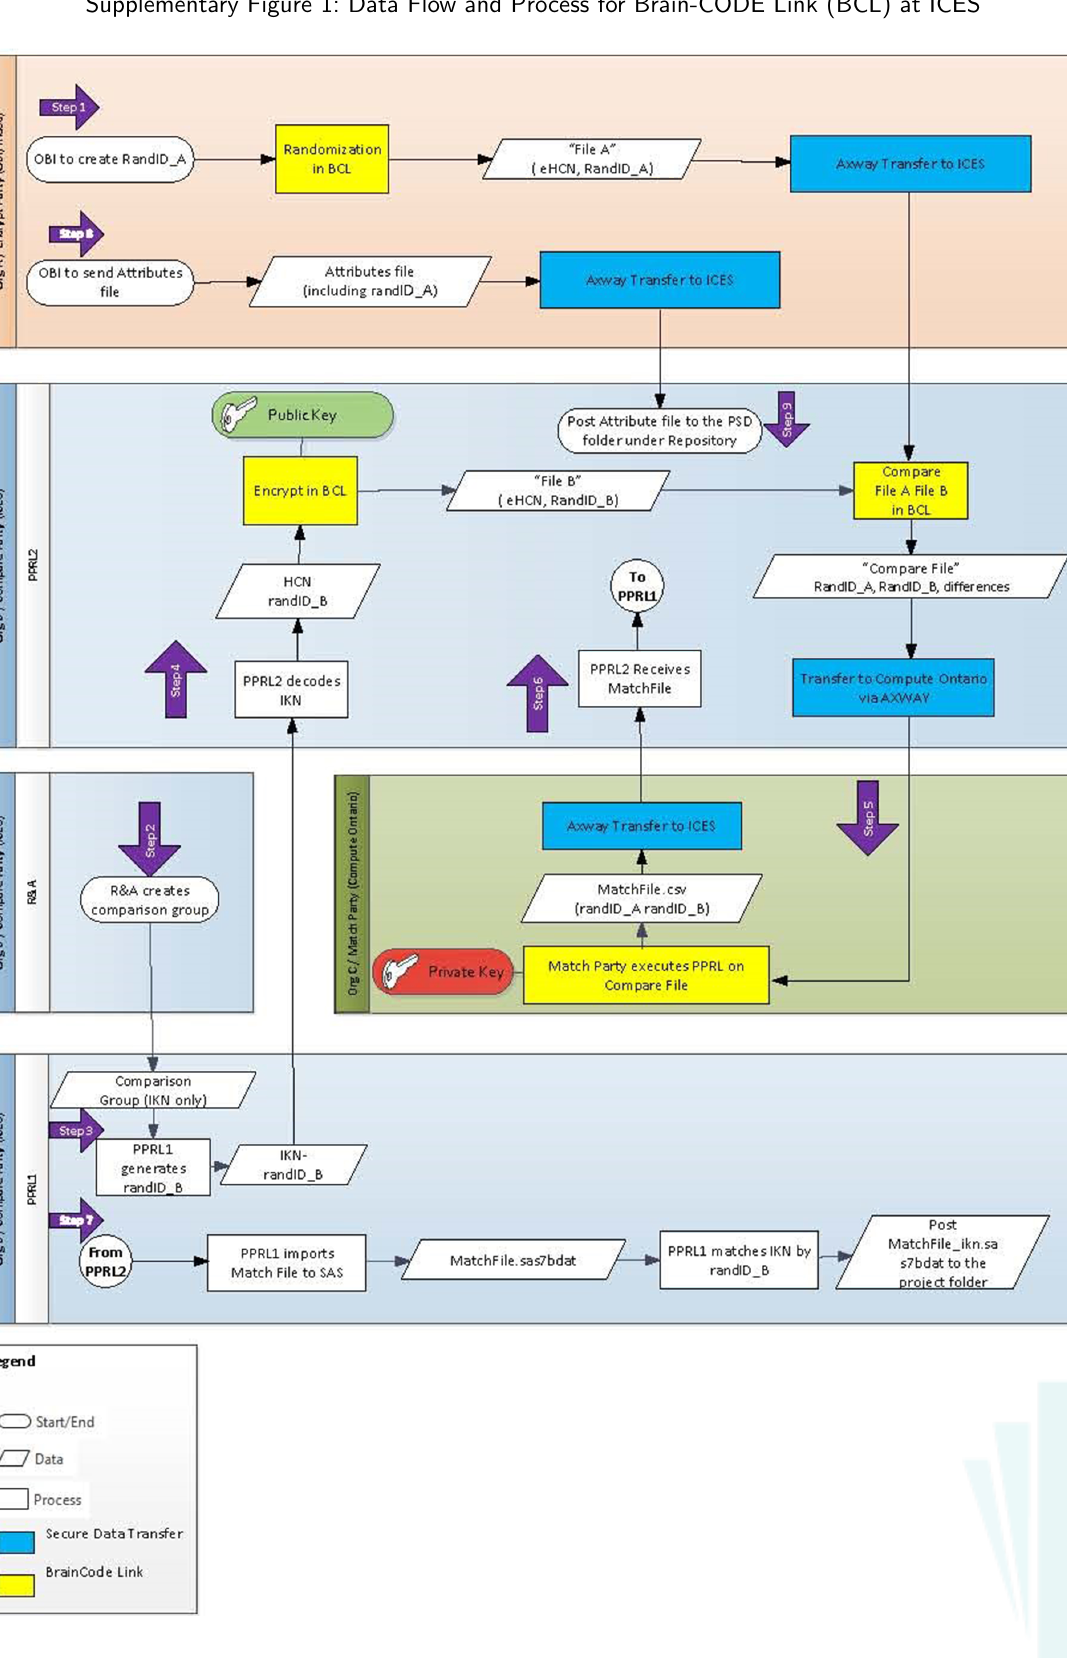
Supplementary Figure 1: Data Flow and Process for Brain-CODE Link (BCL) at